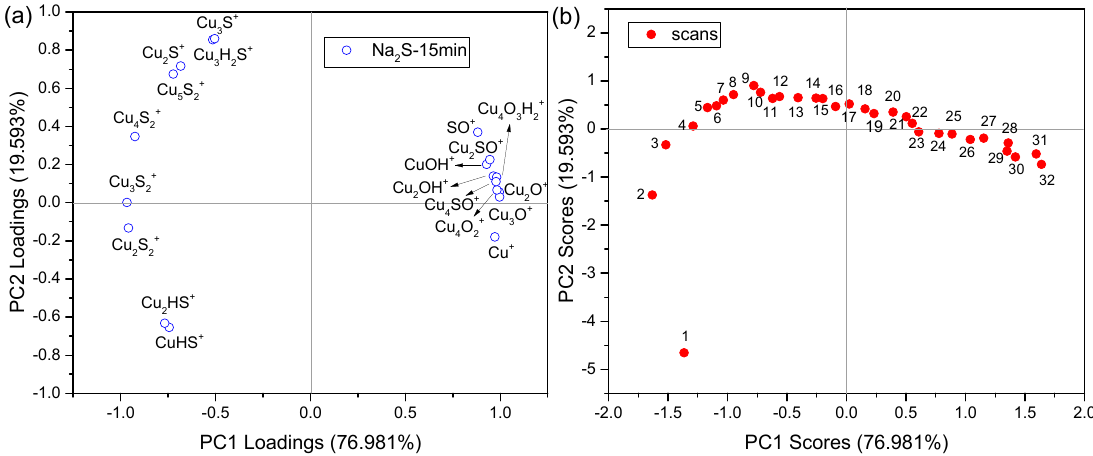
Figure 3. The principal component analysis results for positive spectra of sulfidized malachite at 32 different depths. ( a ): Loadings plot of PCs 1 and 2; ( b ): Scores plot of PCs 1 and 2.